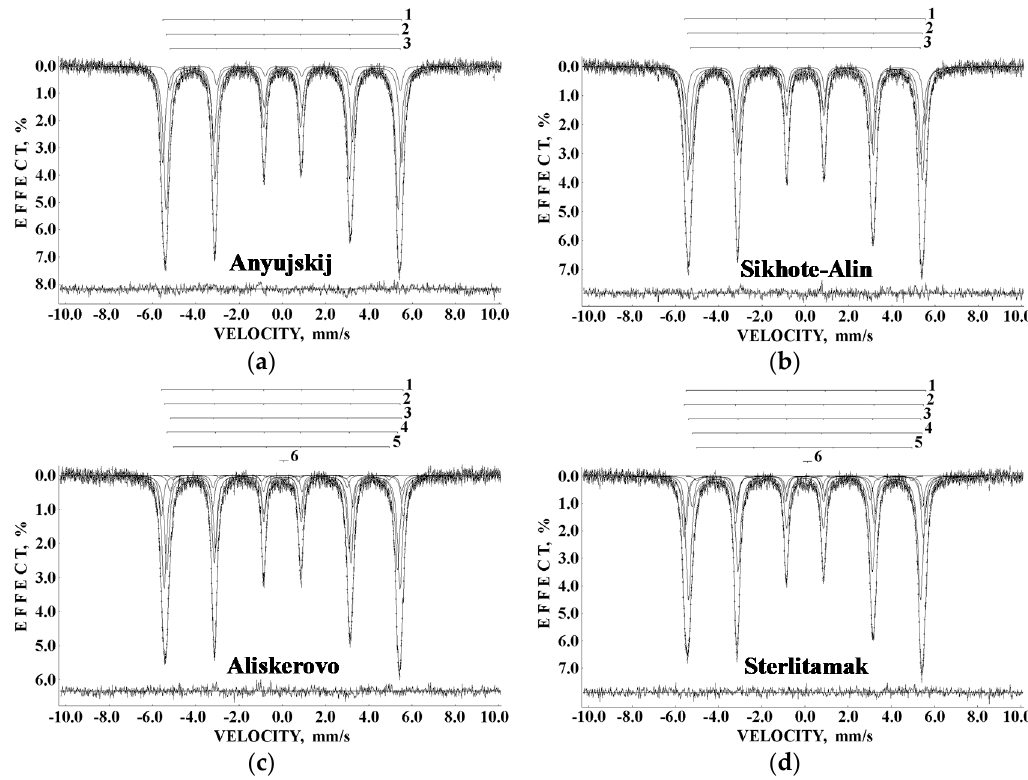
Figure 33. Room temperature Mössbauer spectra of iron meteorites measured with a high-velocity resolution (presentation in 1024 channels): ( a ) Anyujskij IIAB, ( b ) Sikhote-Alin IIAB, ( c ) Aliskerovo IIIE-an, and ( d ) Sterlitamak IIIAB. Indicated components are the results of the best fits. The differential spectra are shown on the bottom. Adapted from [81].